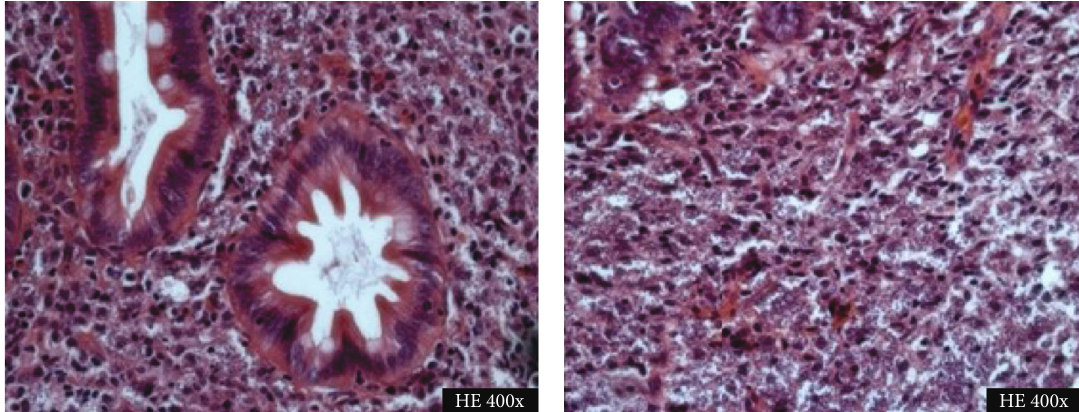
Figure 13: Biopsy specimen of the duodenum of a patient diagnosed with Visceral Leishmaniasis demonstrates extensive in fi ltration with Leishmania bodies. (Images obtained with permission from Cota et al.